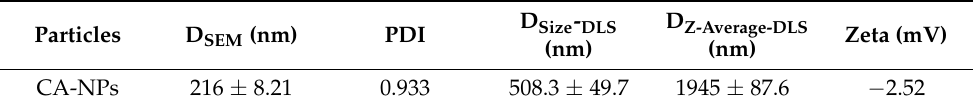
Table 1. Hydrodynamic diameter (D Size-DLS ), the Z average is the intensity-weighted mean hydrody- namic size (D Z-Average-DLS ), and polydispersity index (PDI) of the CA-NPs. The nanoparticle diameter determined by scanning electron micrographs (D SEM ) is also shown.